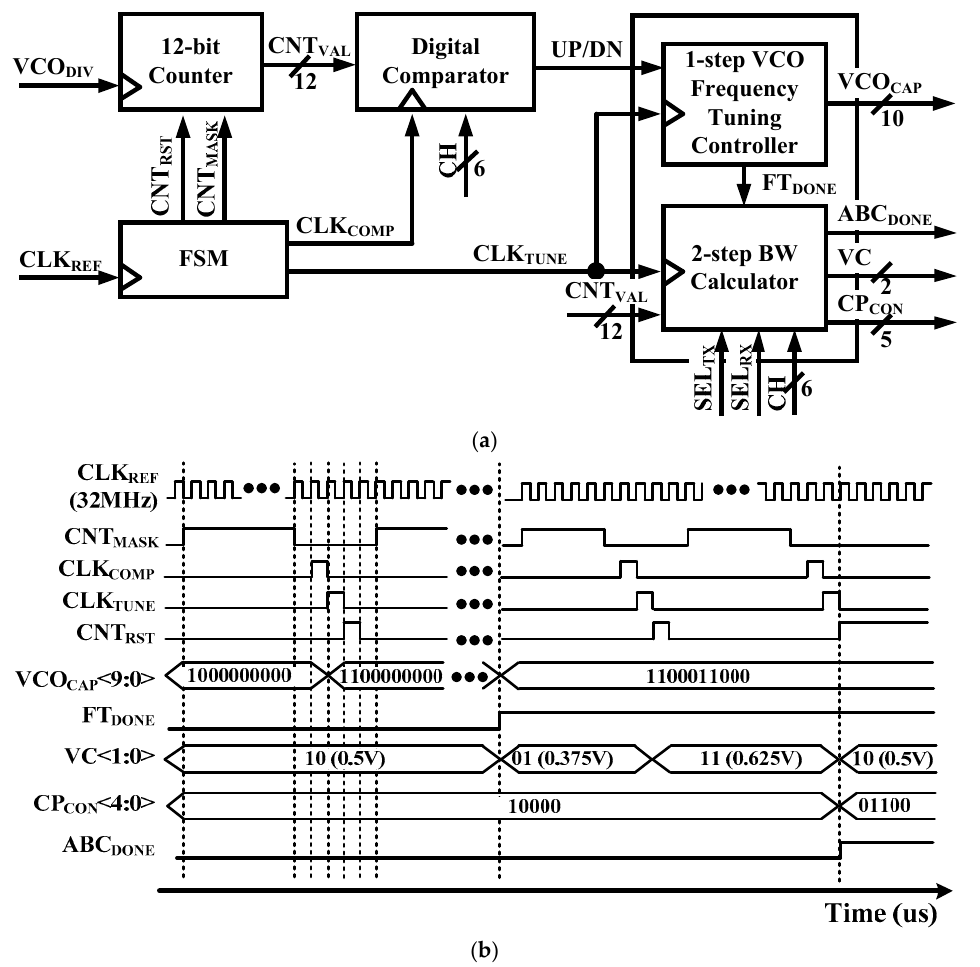
Figure 4. ( a ) Block diagram and ( b ) timing diagram of the ABC block.